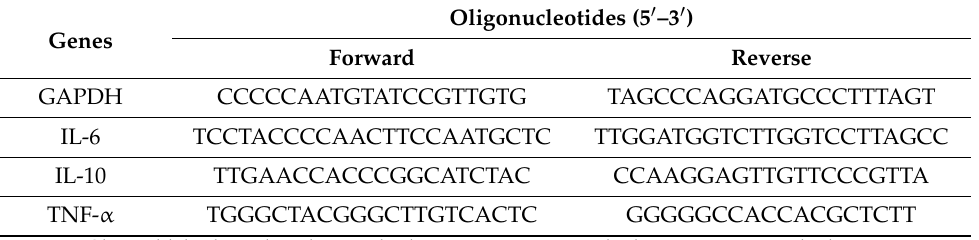
Table 2. Sequences of primers for qPCR